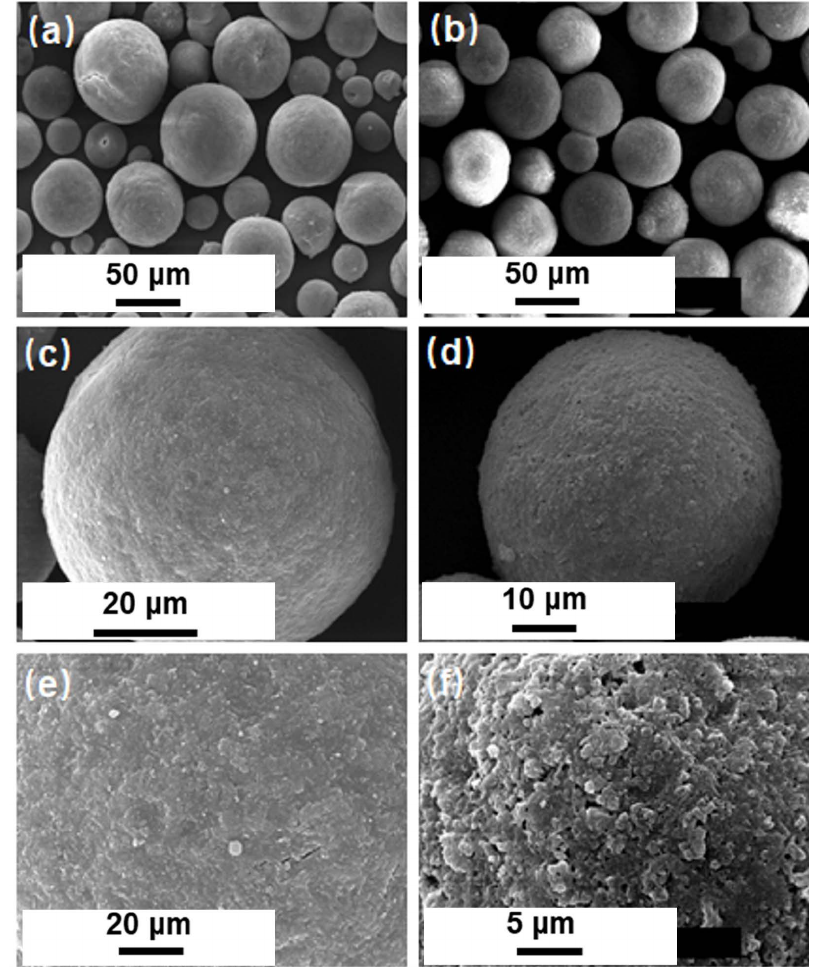
Figure 7. SEM images of prepared FCC catalysts: ( a ) total appearance of Cat-1; ( b ) total appearance of Cat-2; ( c ) single microspheres of Cat-1; ( d ) single microspheres of Cat-2; ( e ) surface detail of Cat-1; ( f ) surface detail of